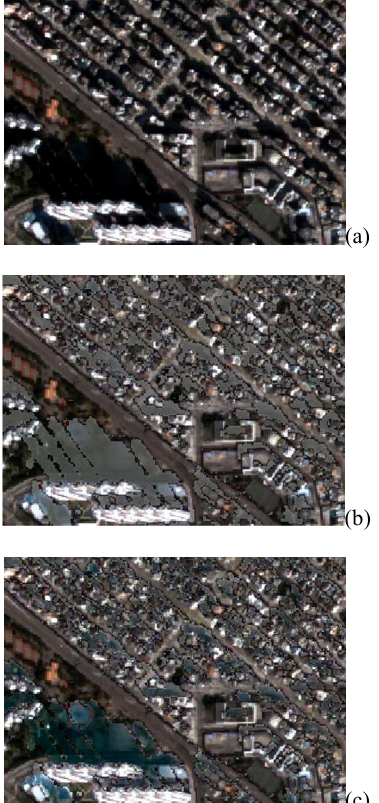
Figure 10. Sham Shui Po - a) Original image; b) By Gamma Correction; c) By Linear-Correlation Correction